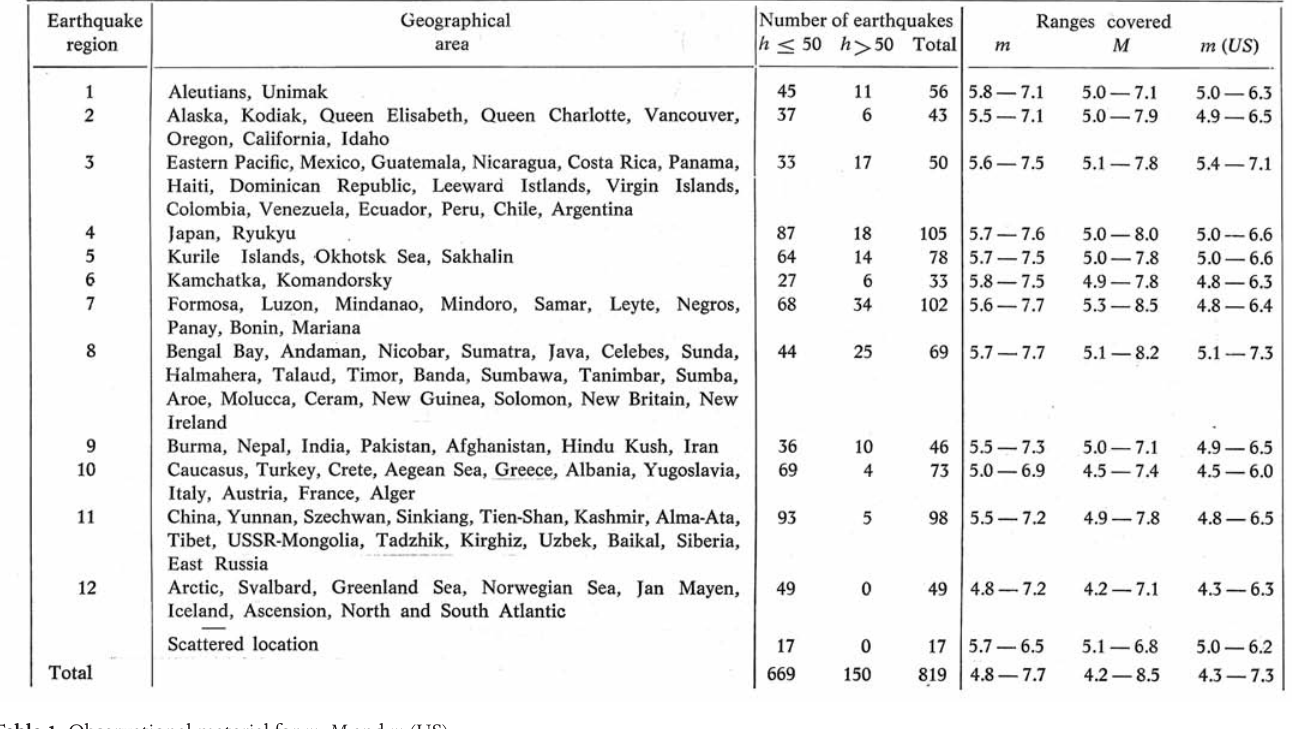
Table 1. Observational material for m , M and m